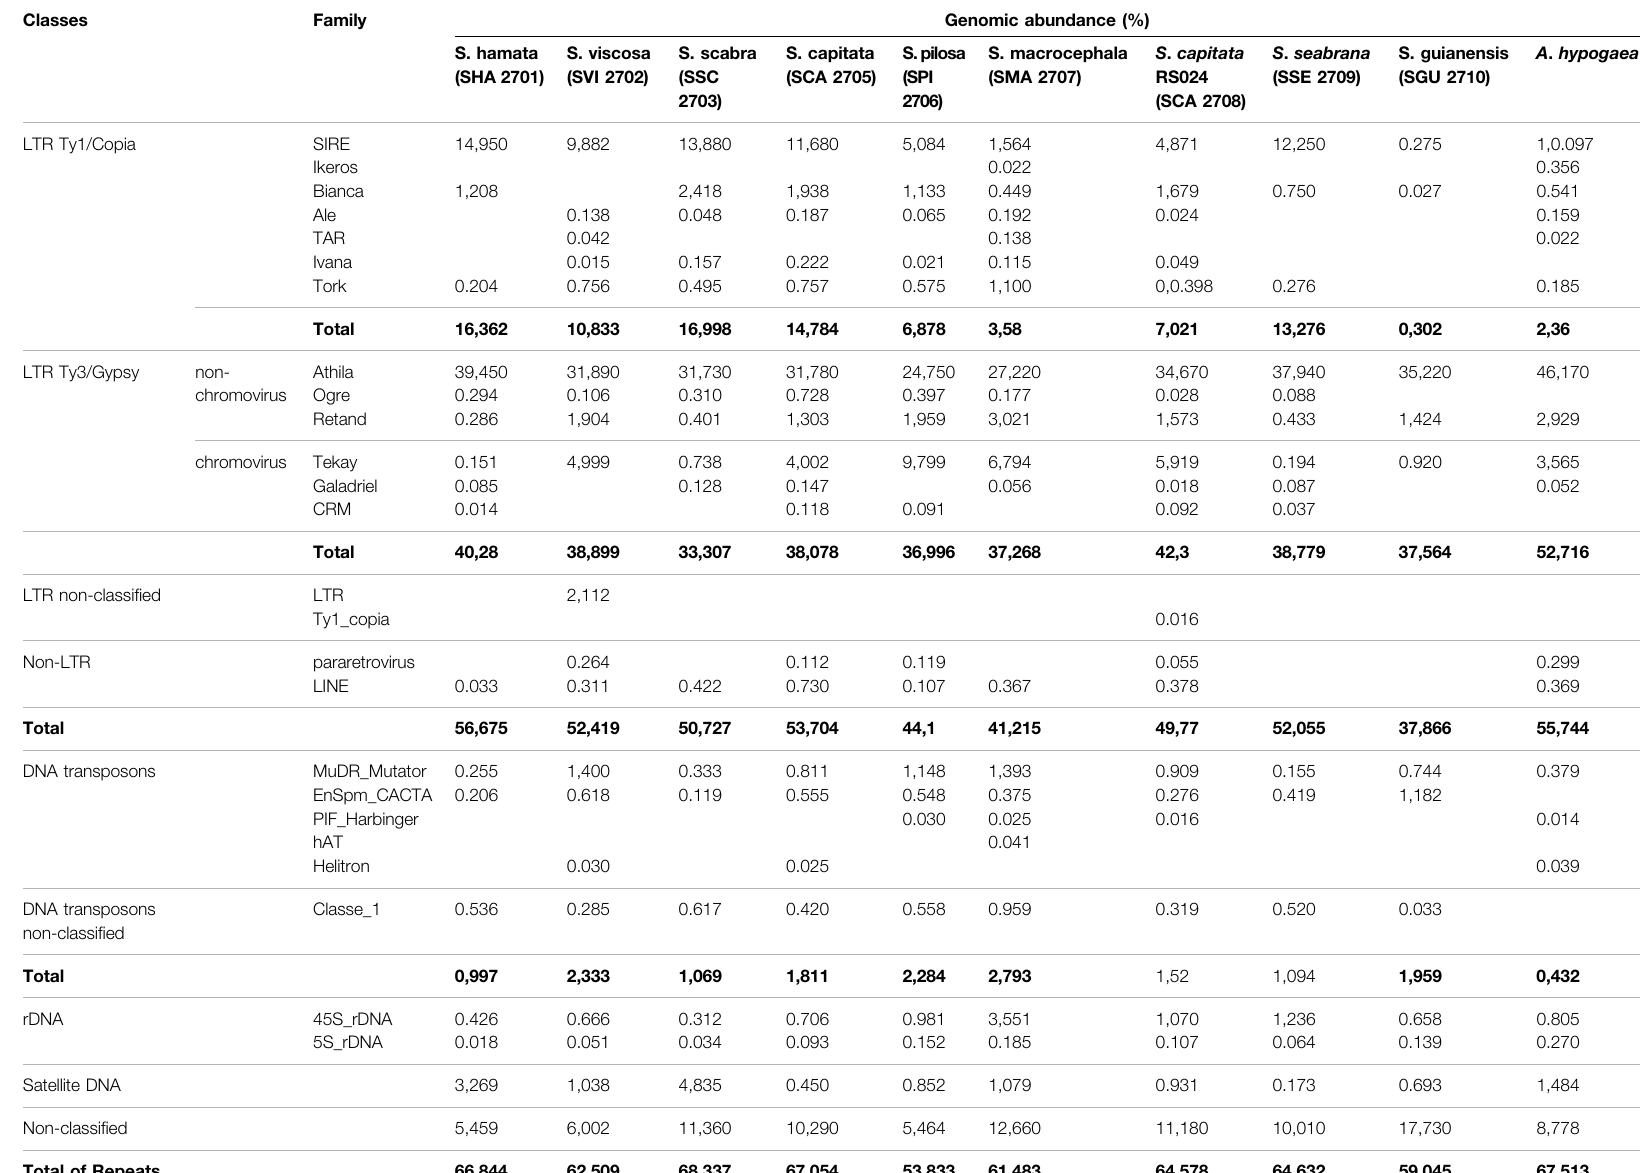
TABLE 2 | Genomic abundances (%) of the main repetitive sequences identi fi ed in the genomes of Stylosanthes and A . hypogaea . Bold values indicate the sum of each individual group of repeats as well as the total sum of repeat